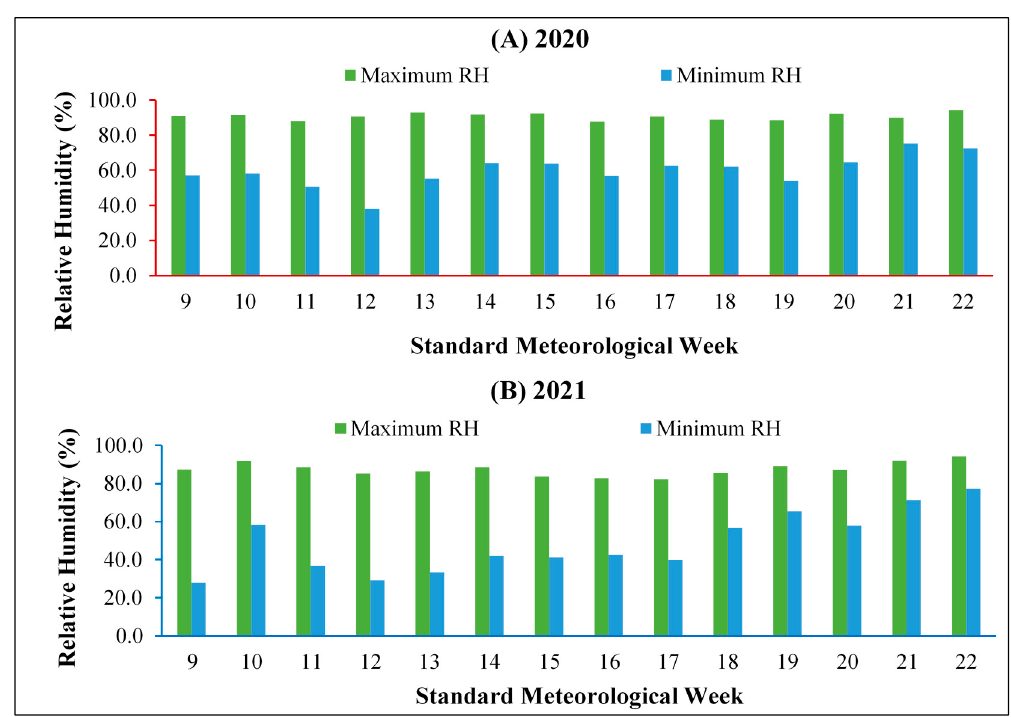
Figure 2. Average weekly distribution of relative humidity during black gram growing period: ( A ) 2020 and ( B ) 2021.